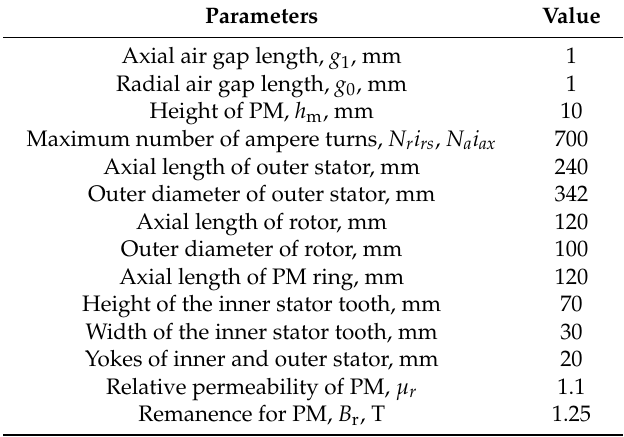
Table 1. Key parameters of the proposed HMB.